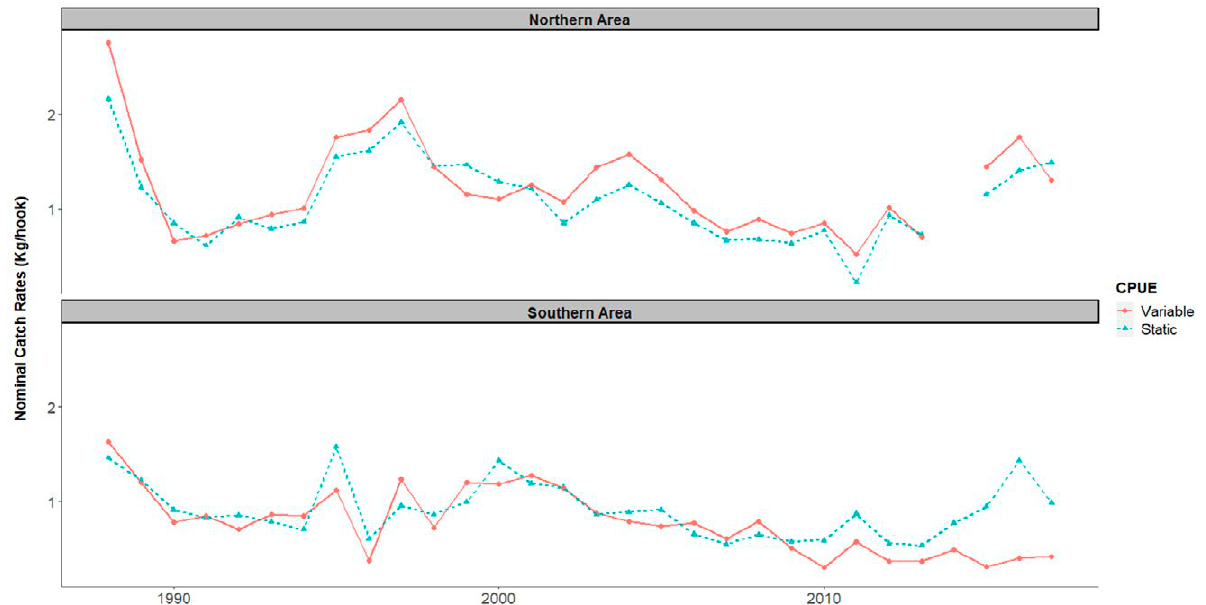
Fig. 6. – Nominal catch rates in the clusters in which pink cusk-eel is caught as targeted using either static or variable fishing tactics (number of clusters) per